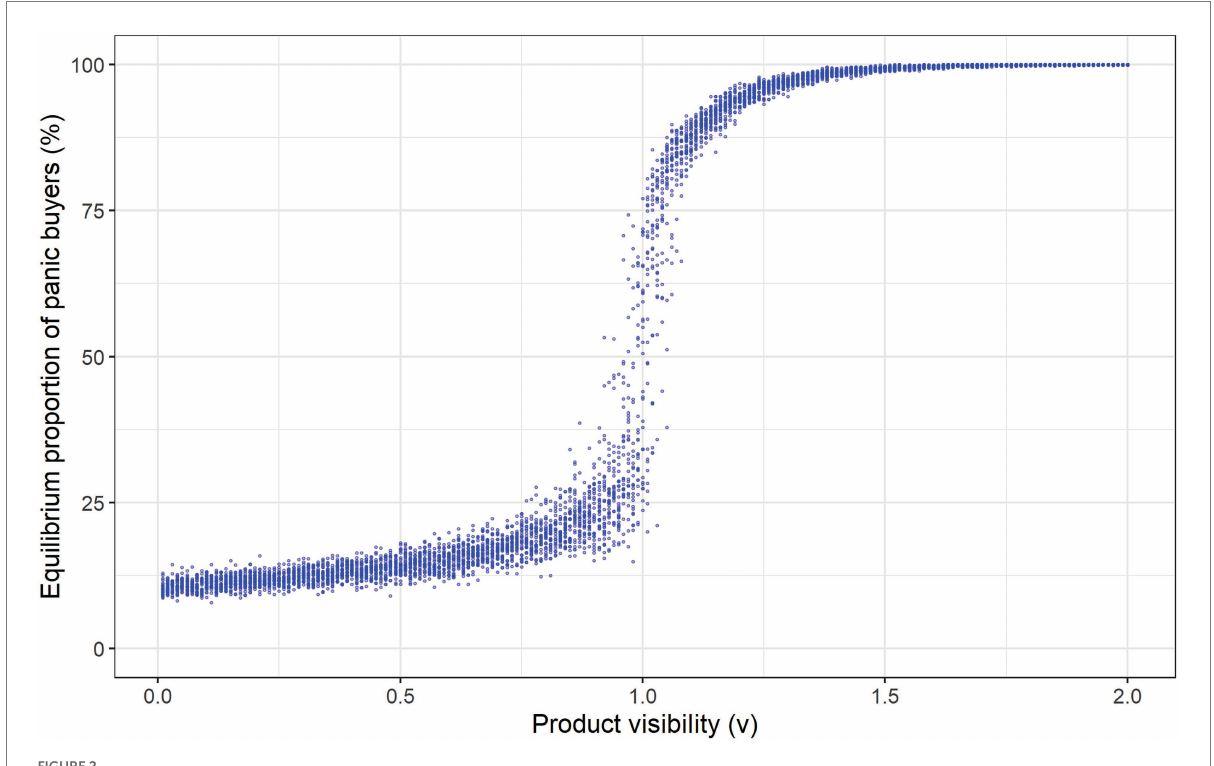
FIGURE 2 Equilibrium levels of panic buying for products with differing